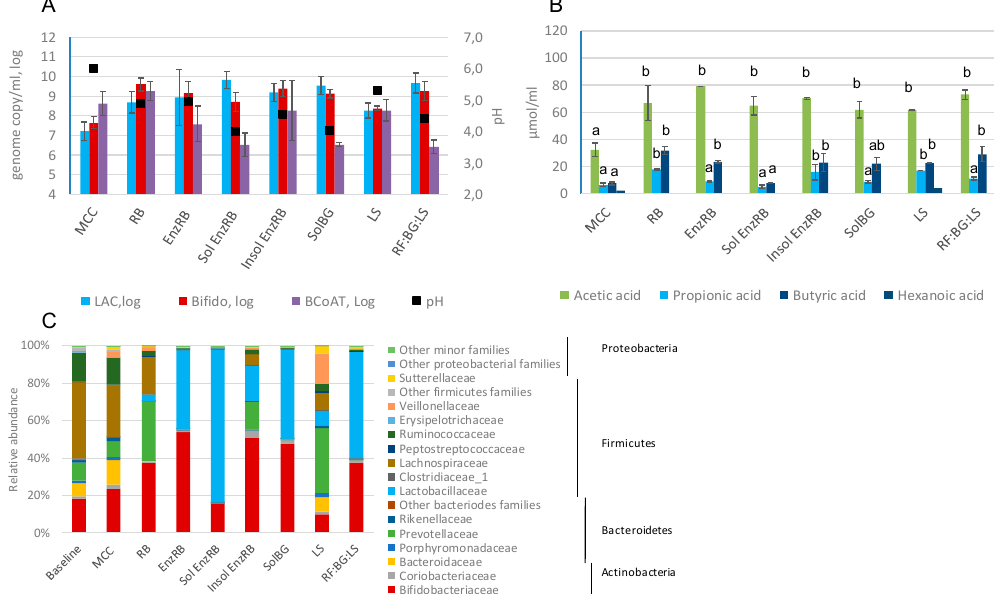
Figure 2. The bacterial population changes and SCFA accumulation after 48 h fermentation of in-house dietary fiber preparations. ( A ) The number of main microbial groups as defined by qPCR; ( B ) the concentration of SCFAs at the end on the fermentation; ( C ) the bacterial community profile at the family level. LAC— Lactobacillus group, Bifido— Bifidobacterium spp., BCoAT—butyryl-CoA:acetate